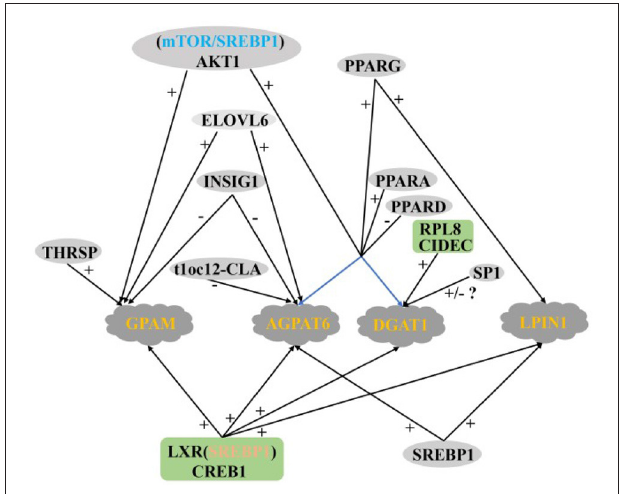
FIGURE 6 | Regulatory network of key genes for MECs lipid droplet secretion in ruminants. + : Positive regulation; –: Negative